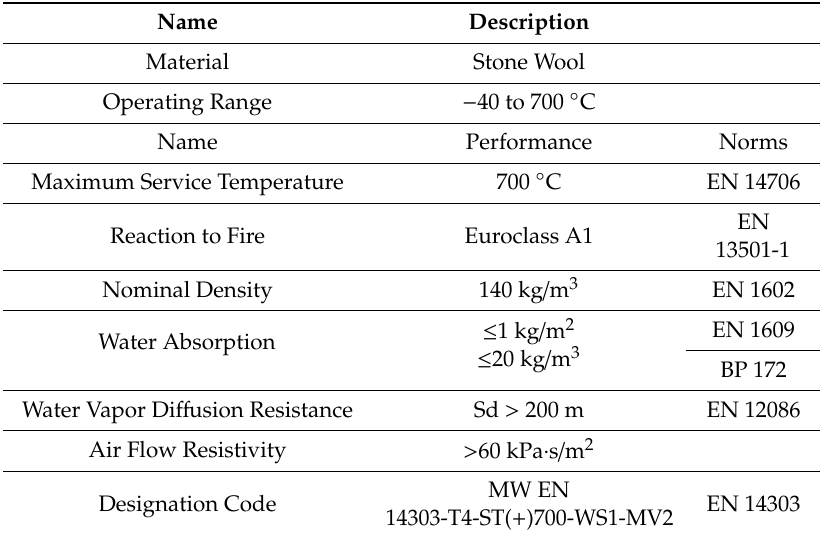
Table A1. Technical data for the Rockwool pipe section mat thermal insulation [29].